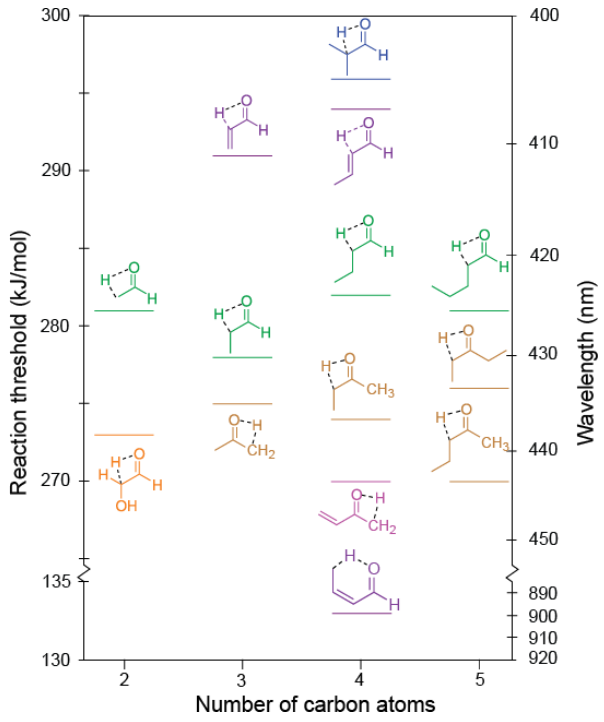
Figure 9. Zero-point vibrational-energy-corrected B2GP-PLYP- D3/def2-TZVP S 0 keto–enol tautomerisation